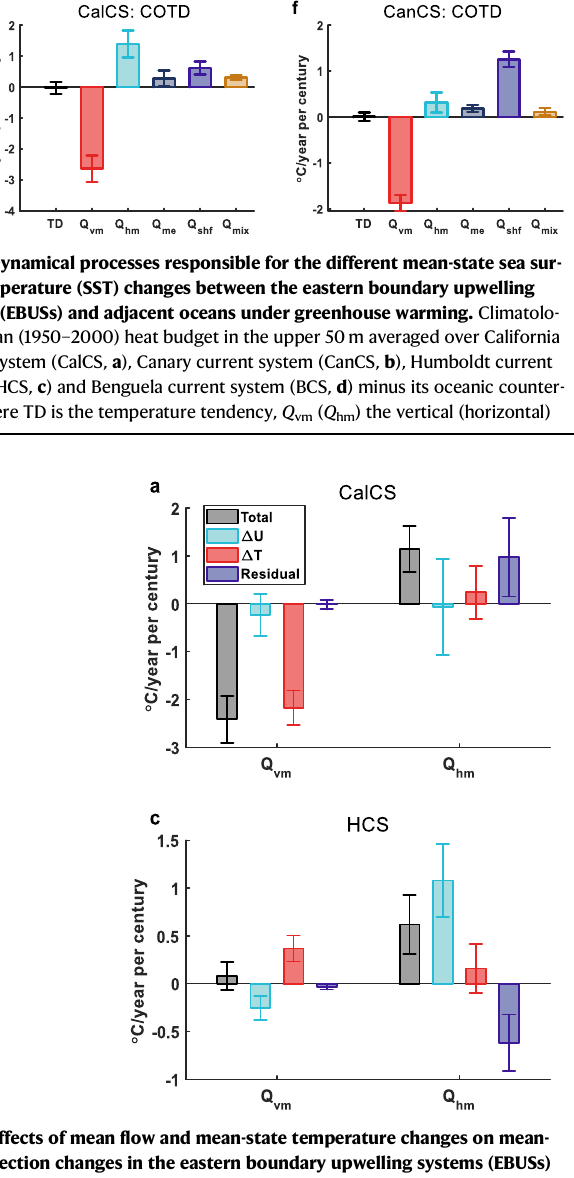
whereas the Q hm change enlarges the mean-state SST increase in the coastal region. In the Northern Hemisphere EBUSs, the enhanced changeisdominantandresponsibleforthe coolinginducedbythe Q vm slower mean-state warming. On the contrary, the additional warming induced by the Q hm change overwhelms the other processes in the Southern Hemisphere EBUSs, causing the faster mean-state warming.